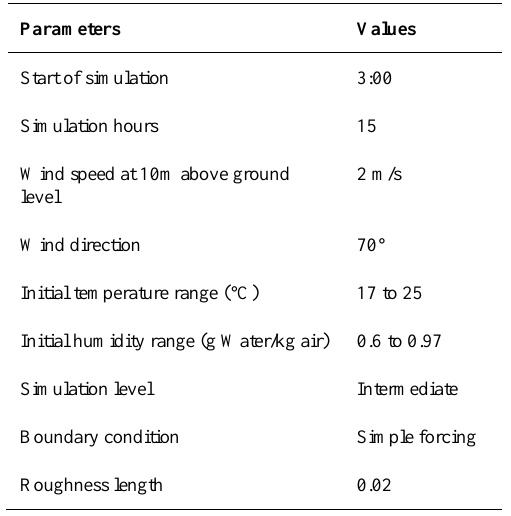
Table 2. Input settings applied to the ENVI-met simulation of current and potential scenarios. The model used intermediate- level simulation with simple forcing from 24 hours